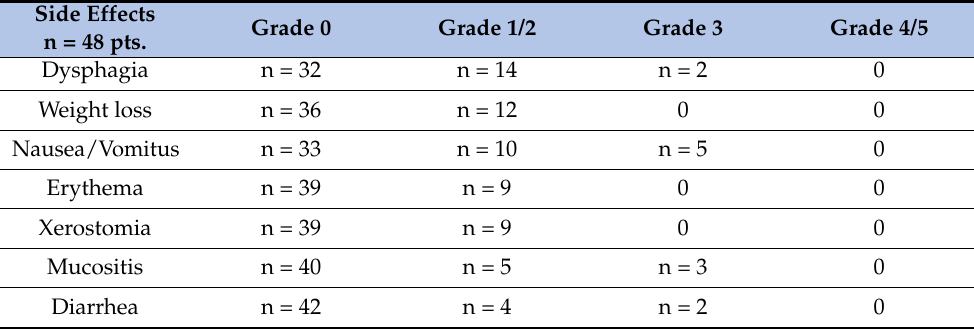
Table 9. Side effects in 48 patients related to the treatment of follicular lymphoma, regarding to the Common Toxicity